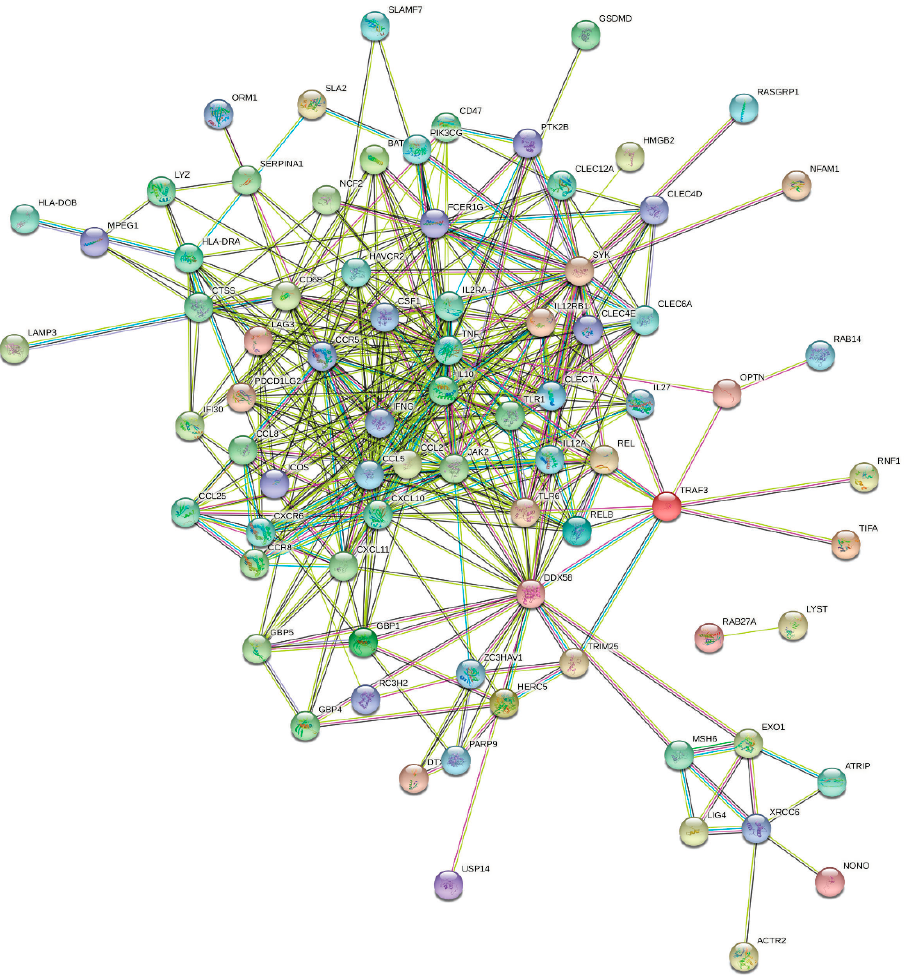
Figure 7. PPI network analysis of an 87-immune-gene signature predictive of pCR. Eighty-seven immune gene signature predictive of pCR were subjected to PPI network analysis using the STRING database. Network statistics: number of nodes: 87; number of edges: 403; average node degree: 9.26; avg. local clustering coefficient: 0.591; expected number of edges: 76; PPI enrichment p -value: <1.0 × 10 − 16 .